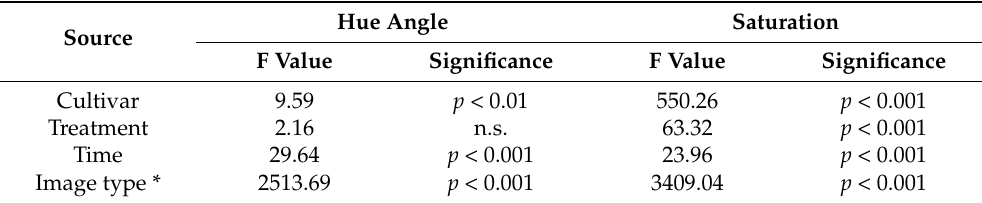
Figure 6. Initial flesh color of ‘Angeleno’ ( a ) and ‘Topend’ ( b ) samples. Table 3. ANOVA F value of main effects on hue and saturation.